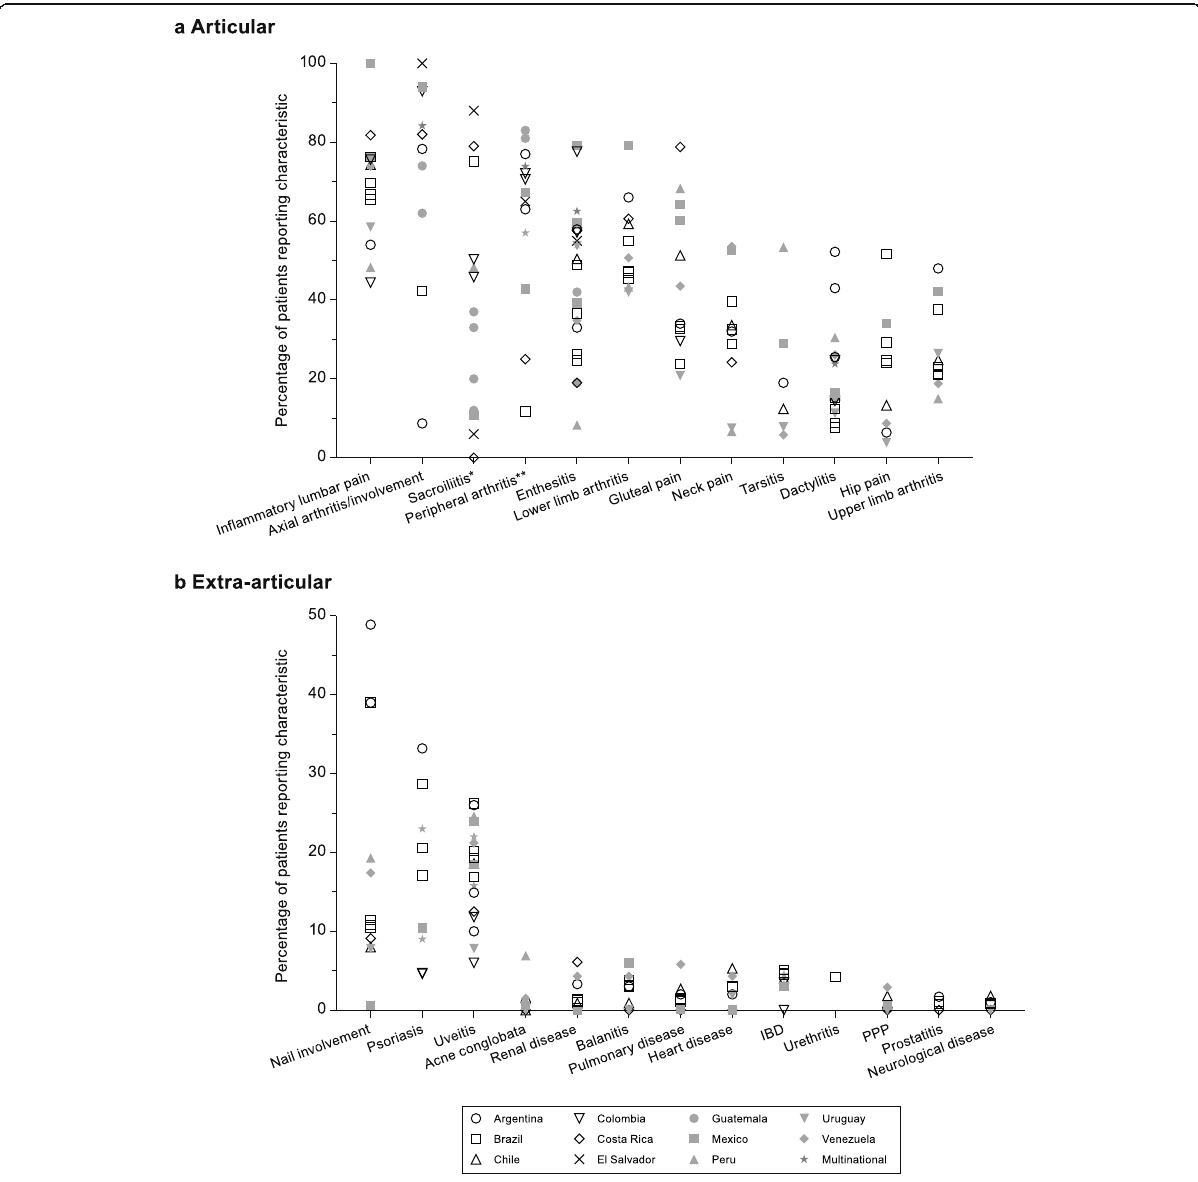
Fig. 1 Disease manifestations in Latin American patients with SpA: a articular; b extra-articular. * Sacroiliitis includes bilateral sacroiliitis, unilateral sacroiliitis, radiographic sacroiliitis, sacroiliitis assessed by MRI, and sacroiliac syndrome. ** Peripheral arthritis includes peripheral arthritis, oligoarthritis, asymmetrical oligoarthritis, and arthritis that is unspecified by the publication. Source data for this figure can be found in Supplementary Tables 1 and 2. IBD, inflammatory bowel disease; MRI, magnetic resonance